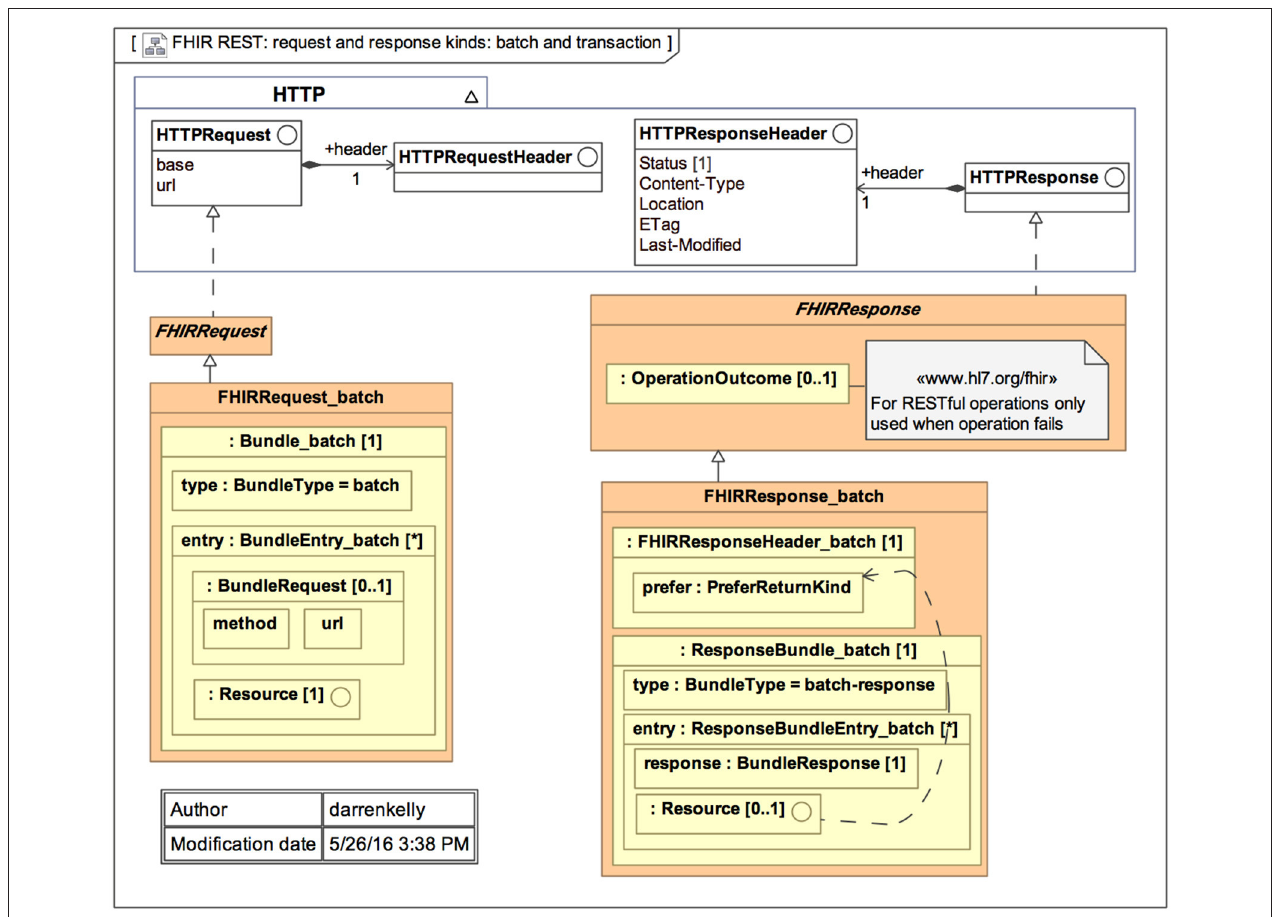
FIGURE 1 | General architecture of the Fast Health Interoperability Resources (FHIR) standard (35).